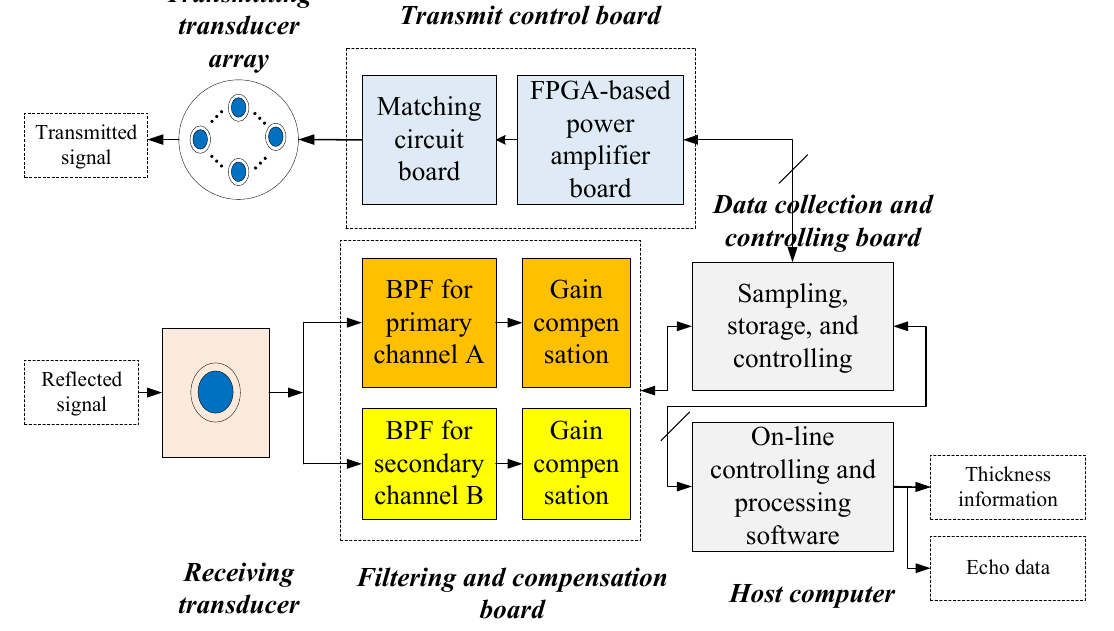
Figure 2. System description of PPPAAP19 with the host computer.